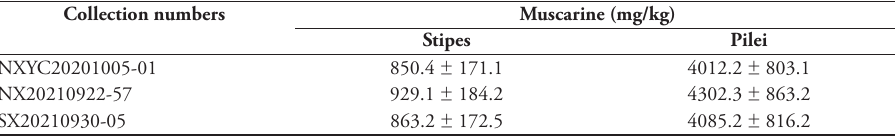
Table 2. Muscarine content in different parts from different specimens collected from different